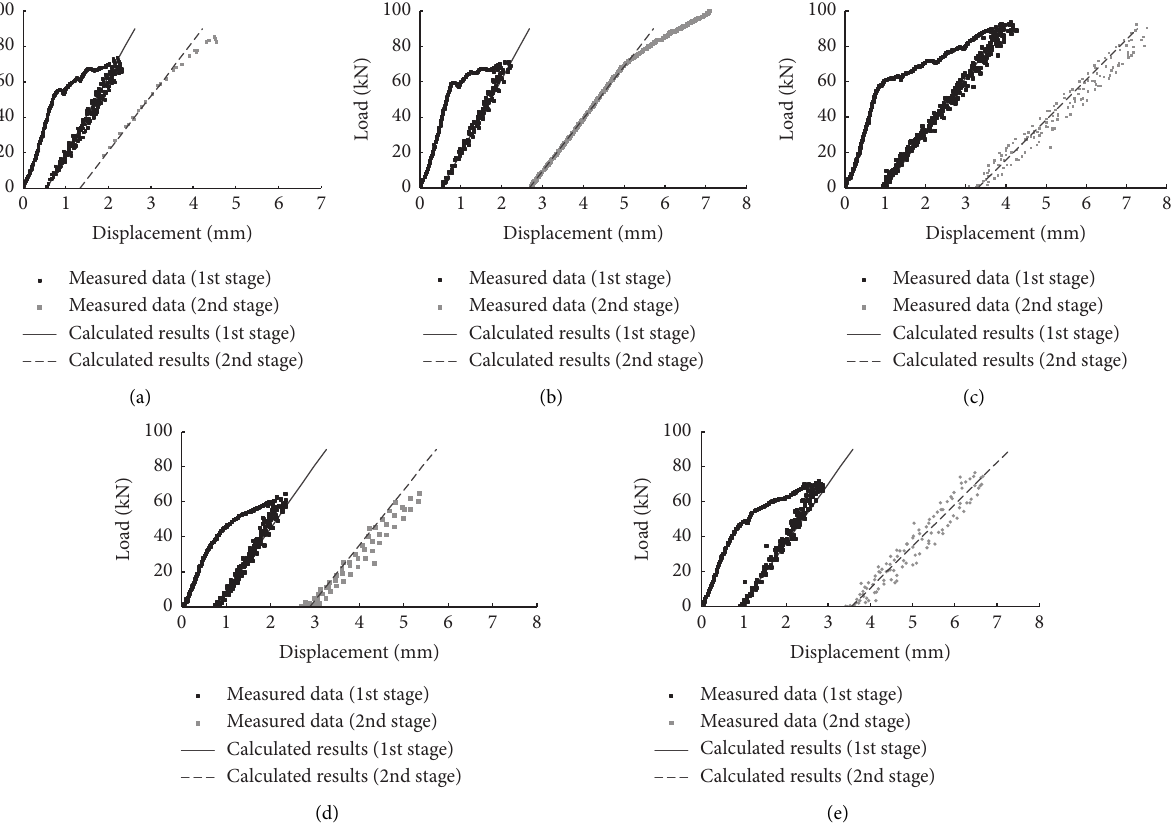
Figure 8: Comparison between calculated and experimental displacements of the beams (a) B1, (b) B2, (c) B3, (d) B5, and (e) B6. Table 4: Calculated and experimental stiffness of the test beams (unit: kN/mm). Test